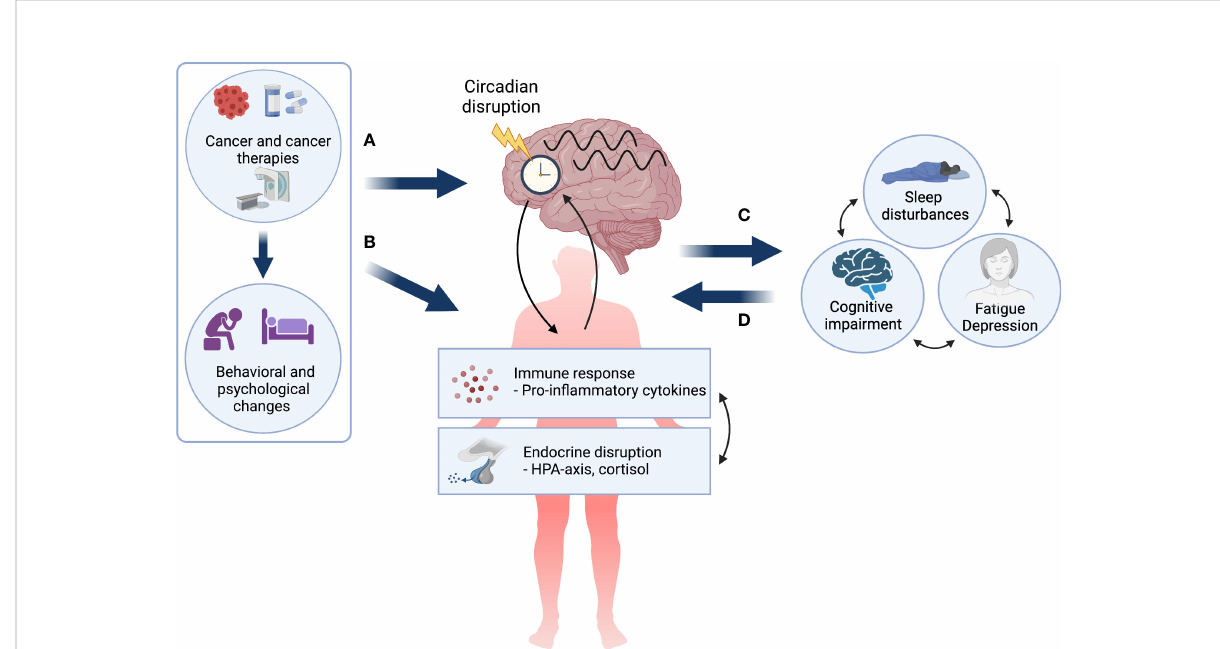
FIGURE 1 The circadian disruption hypothesis of cancer- and cancer treatment-related symptoms. Cancer and its treatment, as well as associated behavioral and psychological changes may (A) directly impact the circadian system resulting in circadian disruption in both biological and behavioral rhythms, and (B) lead to a dysregulated immune response and endocrine disruption, which are themselves bidirectionally linked and may both impact the circadian system. Circadian disruption may result in cancer- and treatment-related symptoms (CTRS) or exacerbate pre- existing symptoms (C) . Finally, it is important to note that once manifested, chronic CTRS burden may further alter both behavioral and pathophysiological factors creating a self-perpetuating negative loop (D) . Created with